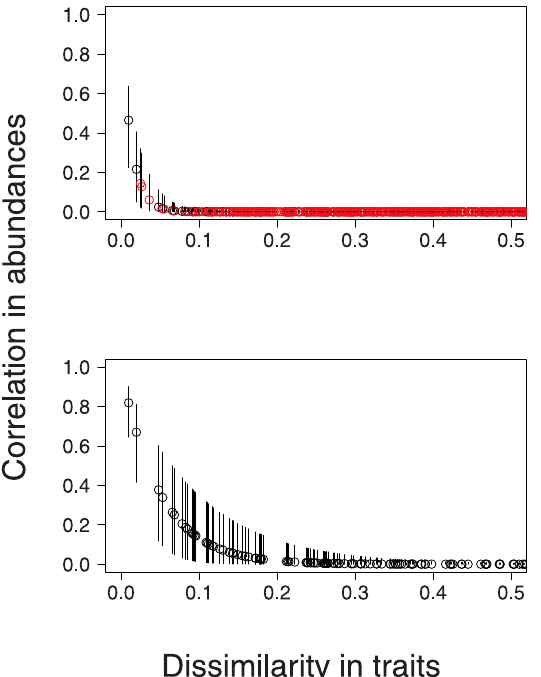
Figure 3. Maximum observed count of ovenbirds and esti- mates of their abundance (posterior means and 95% credible intervals) at sample locations. Dashed line indicates the estimated relationship between mean abundance of ovenbirds and forested area.